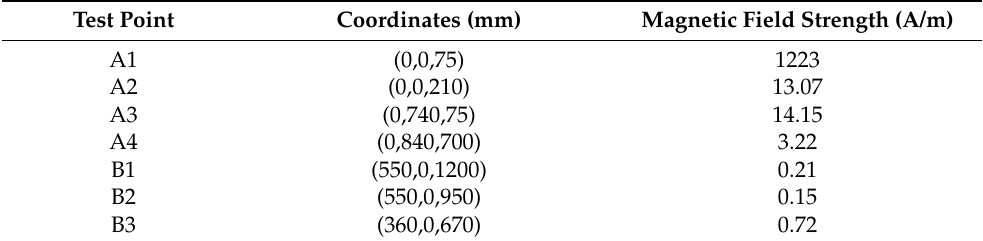
Table 6. Position and magnetic field strength of test